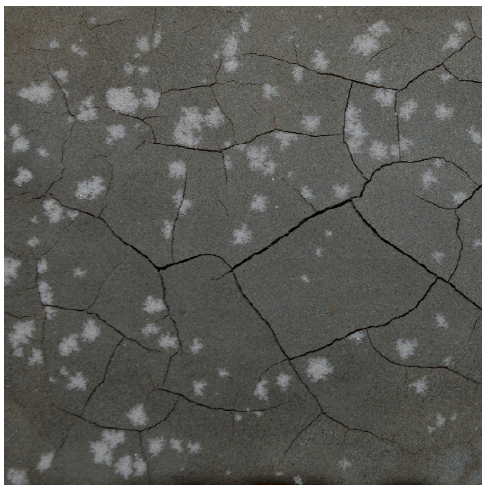
Figure 13. An example of geopolymer coating in batch 2, which demonstrated efflorescence.